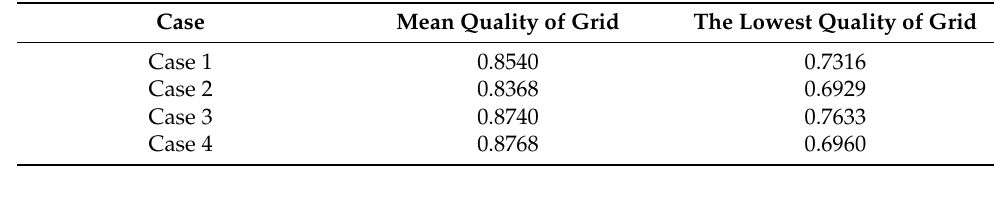
Table 1. Case studies for computational grid resolution.